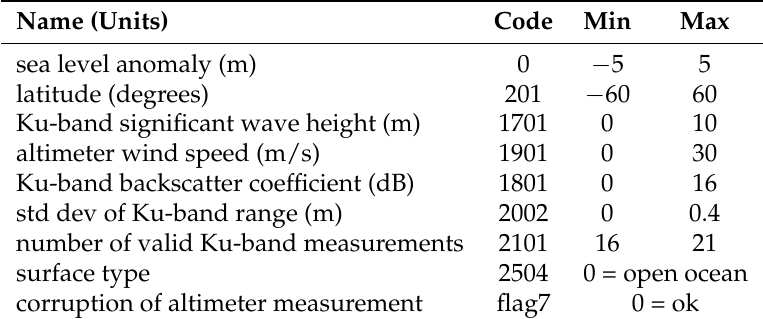
Table 1. Description of the various Radar Altimeter Database System (RADS) parameters and limits used. For this sea state bias (SSB) study, the limits of significant wave height (SWH), wind speed (U10) and σ 0 were chosen in order to use all the available information. Parameters min, max and RADS reference code are